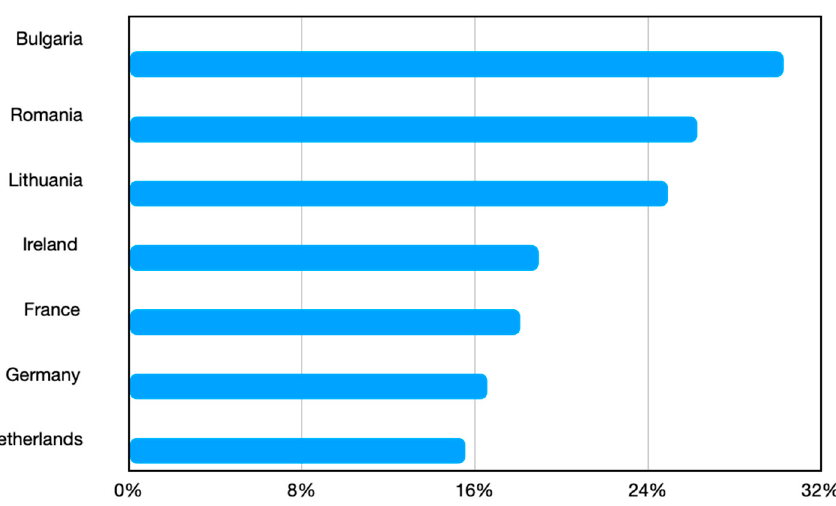
Figure 4. Percentage of women in tech in the EU. Source: Honeypot.com, accessed on 10 September 2021